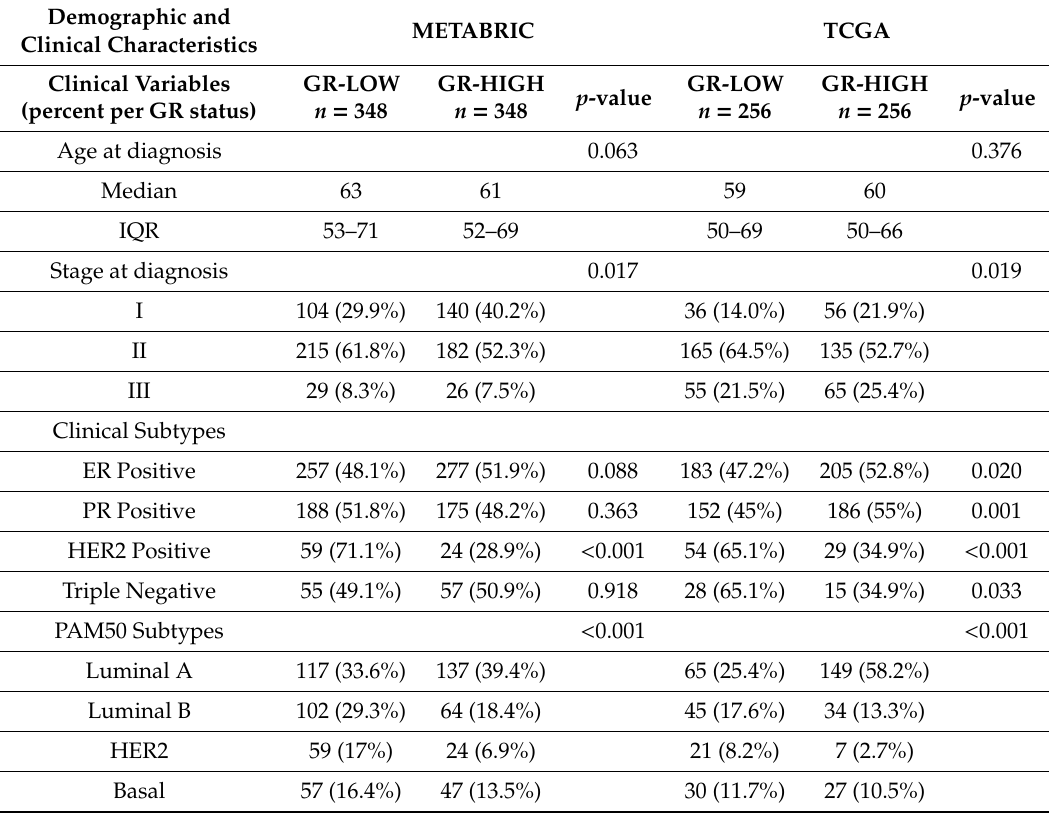
Table 1. Demographic and clinical characteristics of the GR High and GR low breast cancer patients in METABRIC and TCGA in the entire